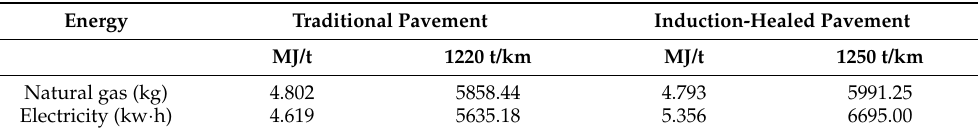
Table 5. Energy consumption in the preparation of asphalt mixture.